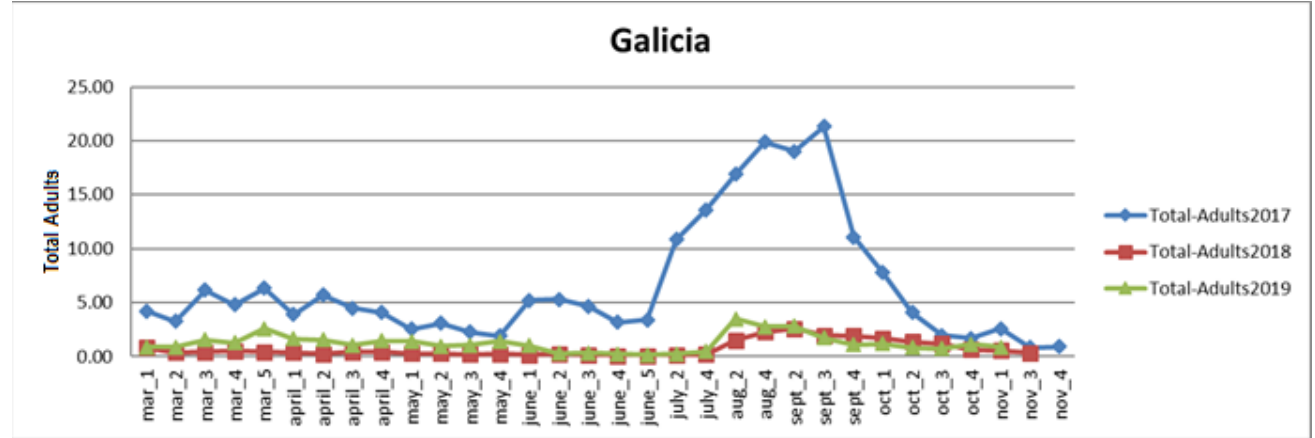
The total number of adults was also evaluated for each year according to the survey (Figure 7). In this case, the dates are shown by the number of the week in the month, as they are not the same each year.